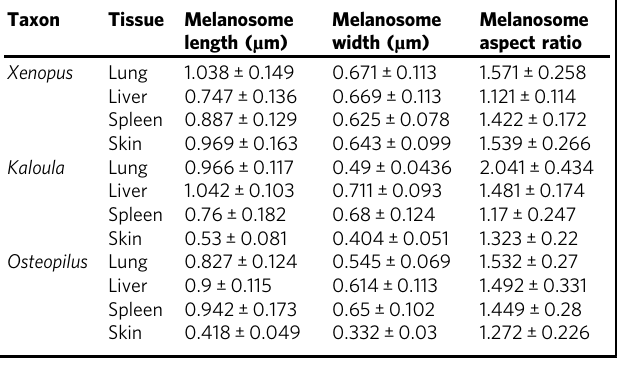
Table 3 Geometry of melanosomes in extant Xenopus , Kaloula and